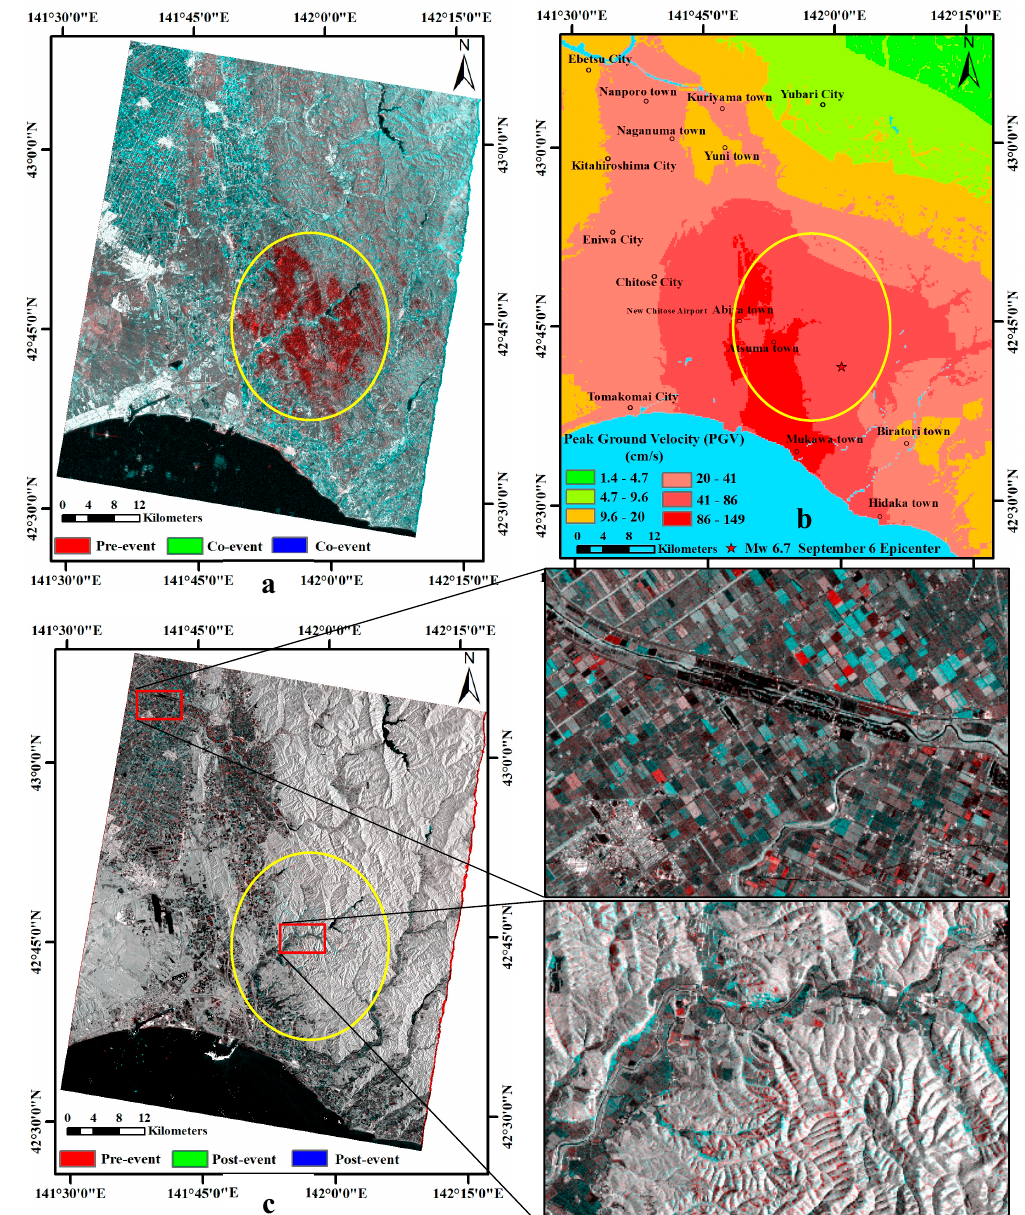
Figure 15. Color composite image of coherence from descending PALSAR-2 pairs ( a ); peak ground velocity around the Atsuma town on September 6, 2018 ( b ), downloaded from QuiQuake: https: // gbank.gsj.jp / QuiQuake / QuakeMap / index.en.html.; the color composite of backscattering intensity from descending PALSAR-2 images ( c ).